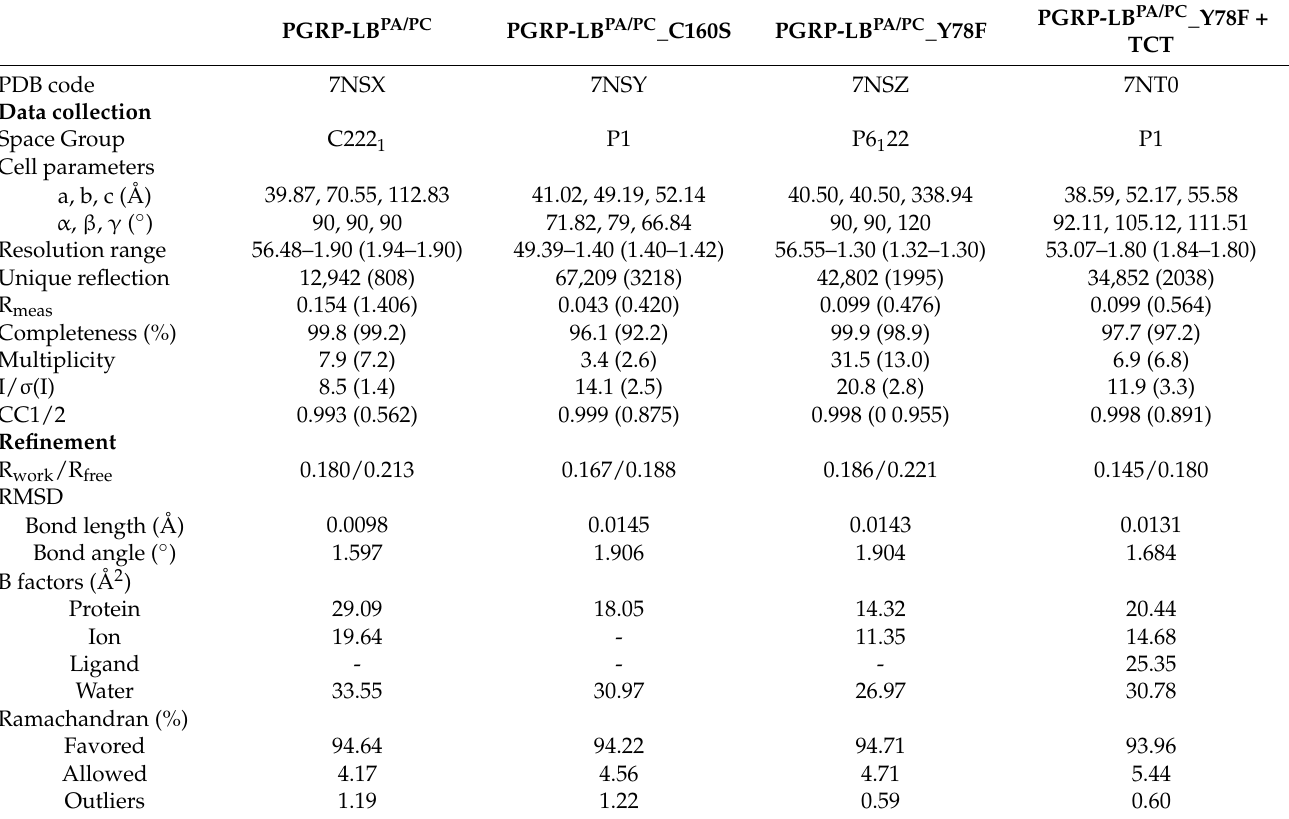
Table 2. Data collection and structure refinement